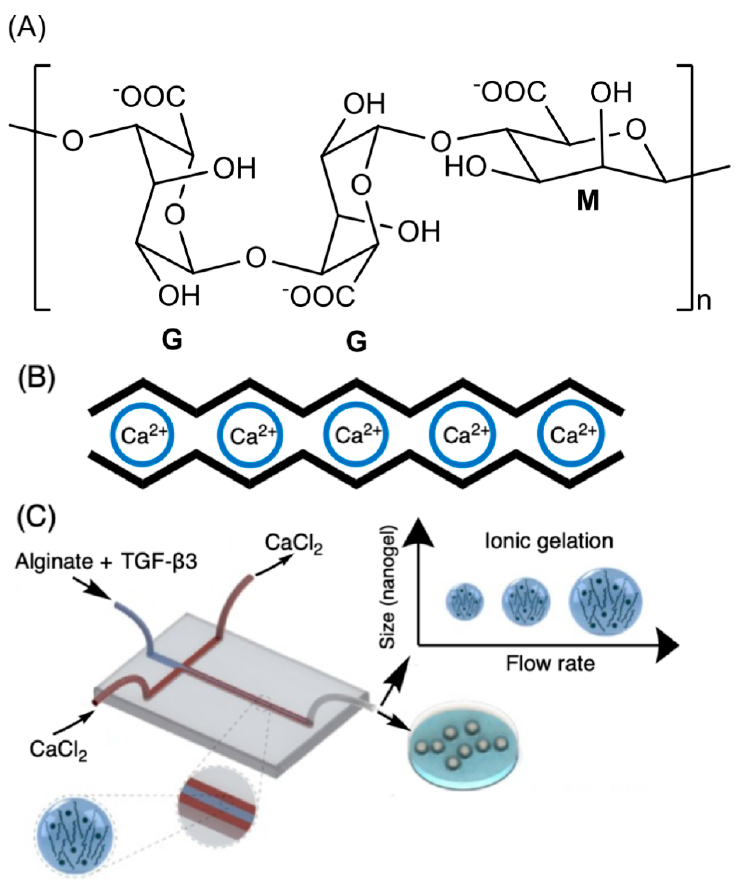
Figure 4. Chemical alginate structure ( A ), well-established egg-box gelation of alginate with cal- cium ions ( B ), and schematic illustration of a microfluidic device for hydrodynamic flow-focusing consisting of one inlet for focusing (core) flow and two separate inlets for the sheath (side) flows. ( C ) Adapted with permission from [88]; published by Elsevier, 2020.